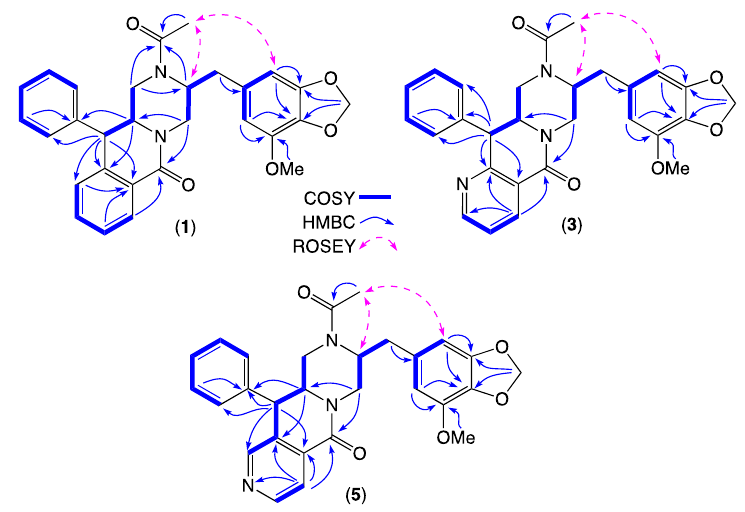
Figure 5. Diagnostic 2D NMR (DMSO- d 6 ) correlations for 1 , 3 and 5 .